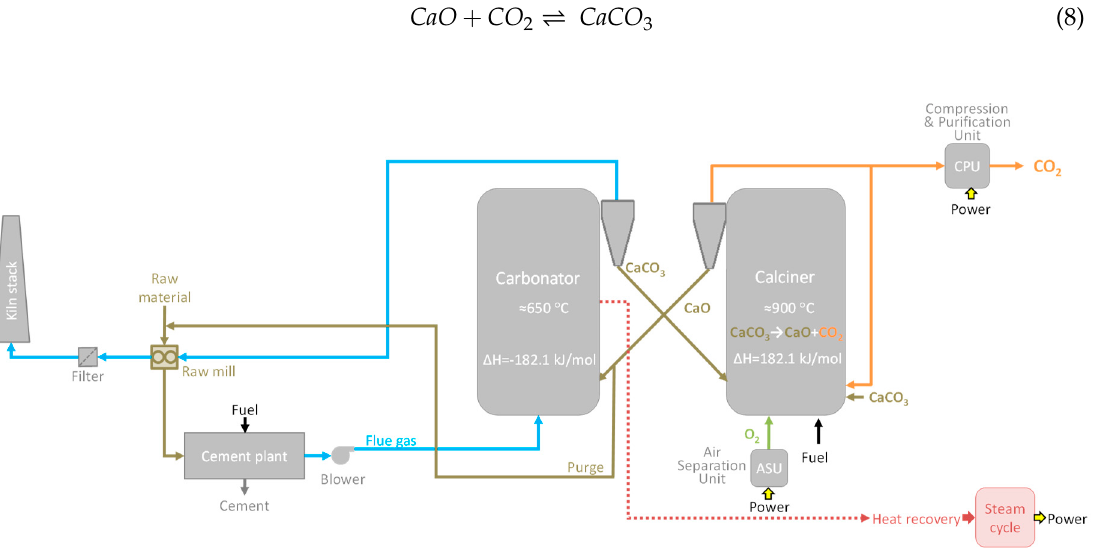
Figure 12. Simplified diagram flow of a CaL process installed in a cement plant: integrated configuration (adapted from [46]).